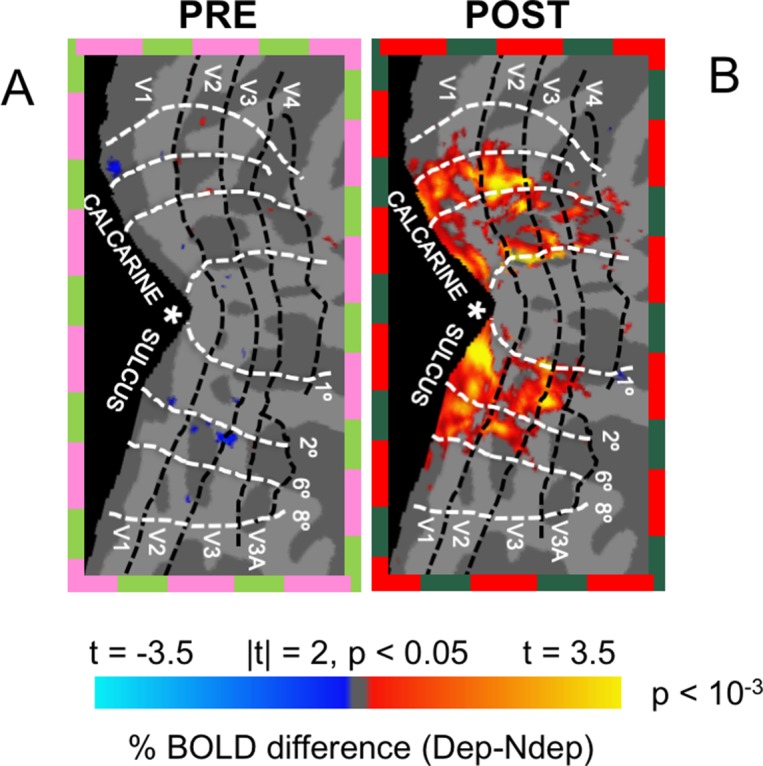
Change of ocular preference after deprivation.Panels (A) and (B) map the difference of the %BOLD response to the Deprived – Non deprived eye, before and after deprivation, respectively. While there is no organized preference for either eye in any visual area before deprivation, there is a clear preference for the deprived eye after deprivation (the net result of the boost of the deprived eye response and the suppression of the non deprived eye response), which spreads across most of the areas activated by our stimulation.